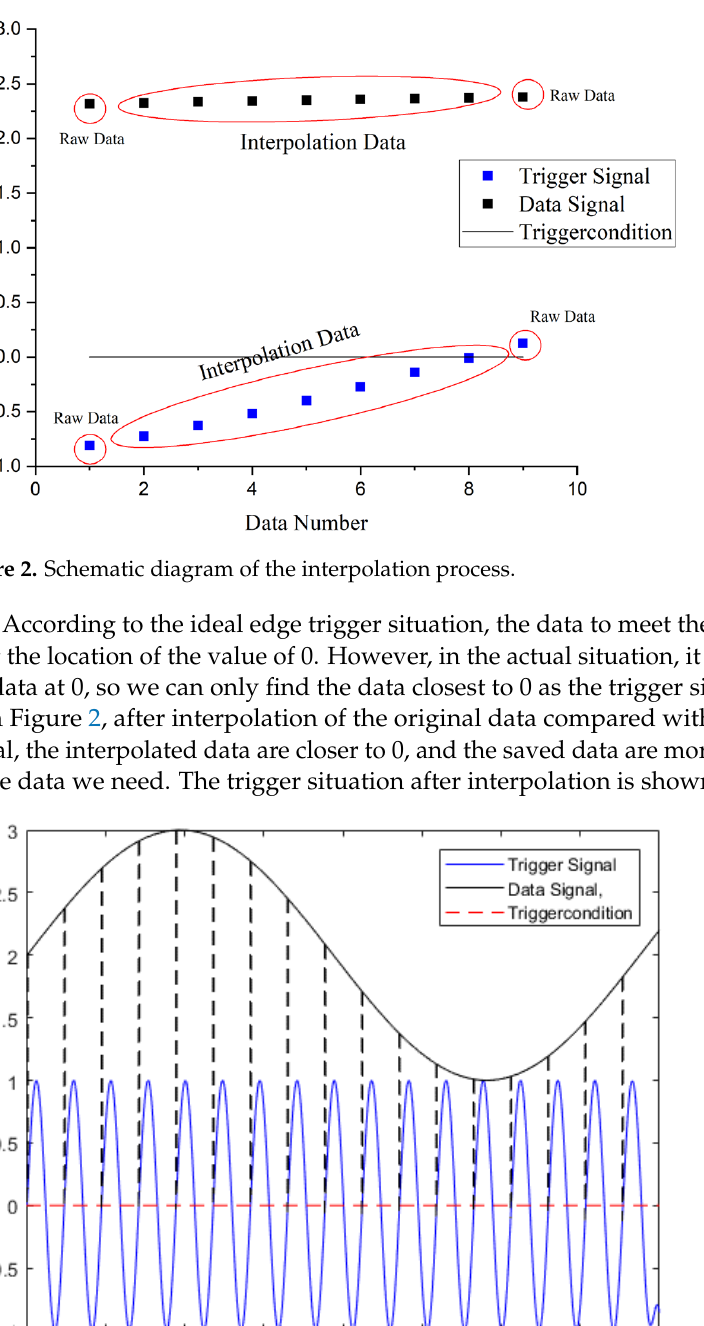
Figure 3. Schematic diagram of the trigger after interpolation.